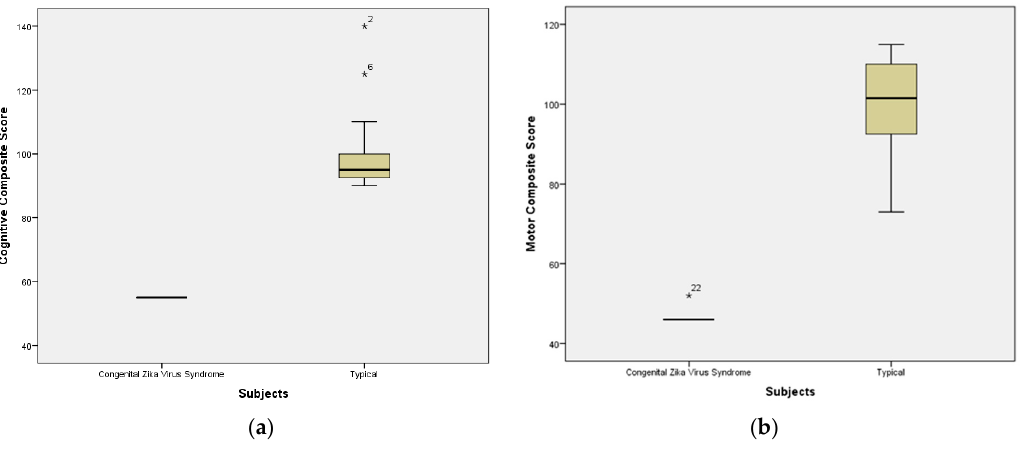
Figure 2. ( a ) Cognitive Composite Score divided by groups; ( b ) Motor composite score divided by groups (n = 8 group A; n = 16 group B).